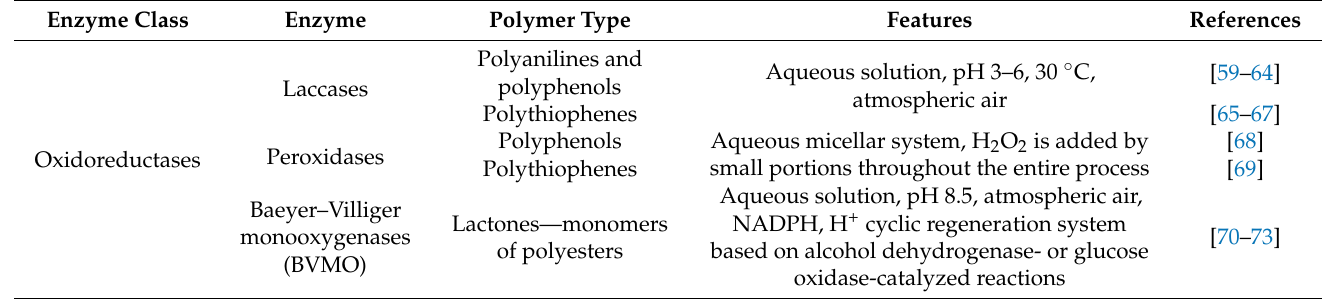
Table 2. Enzymes and polymers produced with